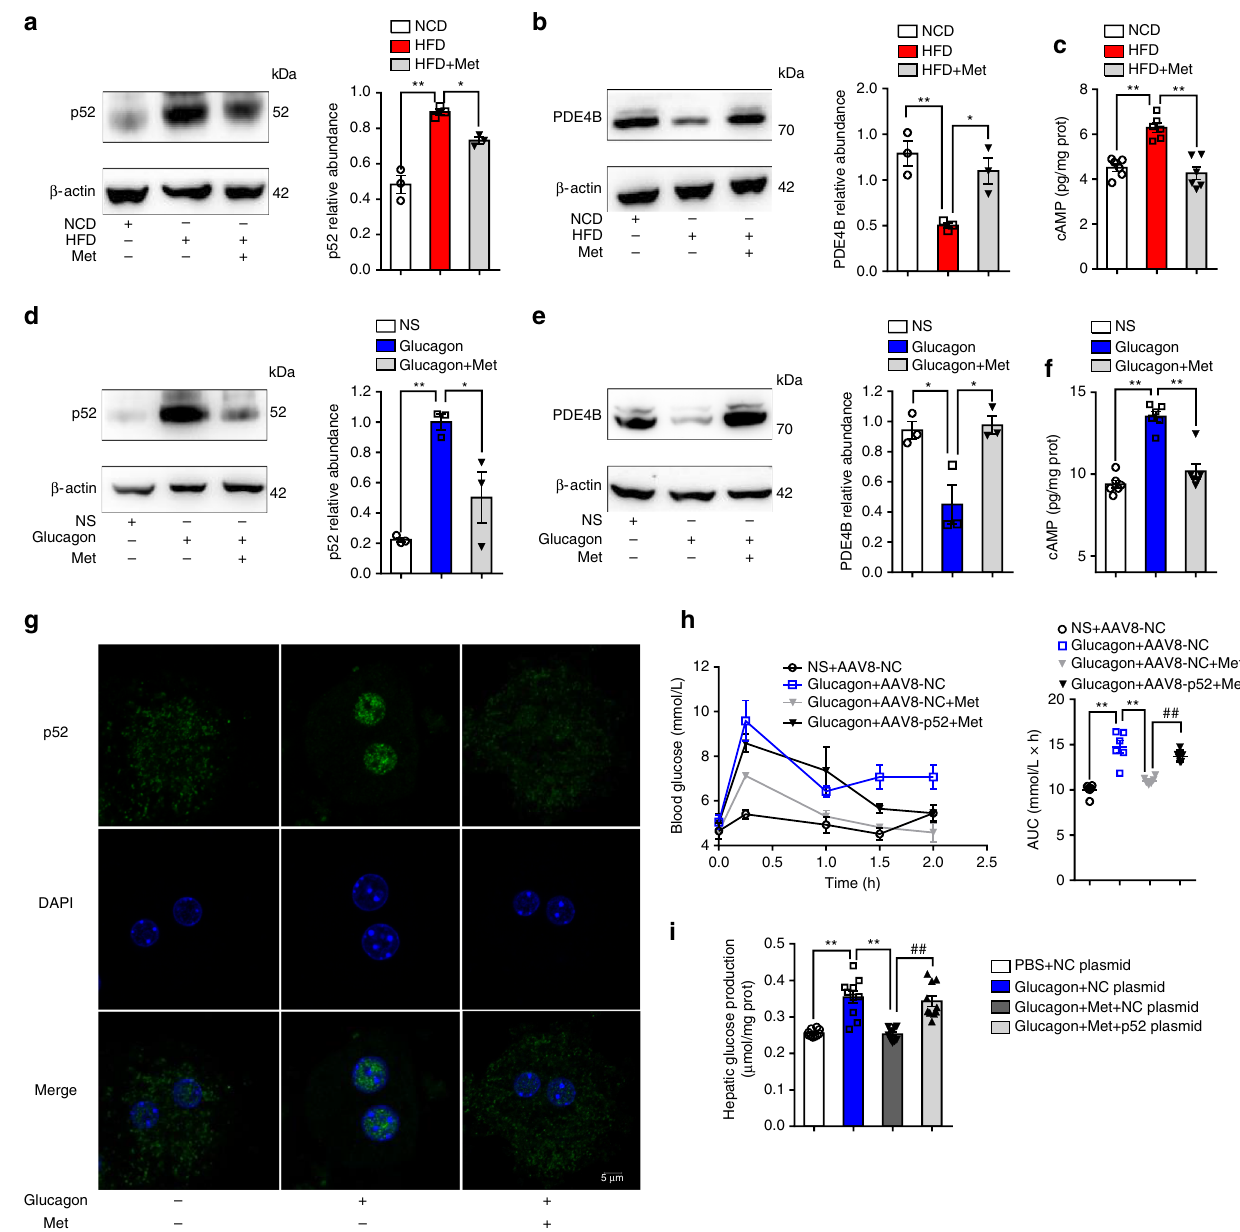
Fig. 5 Metformin alleviates hyperglycemia by inhibiting p52 activation. a , b Western blotting analysis of p52 ( a ) and PDE4B ( b ) using liver lysates of mice fed with the indicated diet for 8 weeks. Each lane represents a liver lysate from a different animal. Bar graphs represent the data normalized to β -actin ( n = 3). Metformin (200 mg/kg/d) was administrated by gavage for 8 weeks. c The cAMP levels in the liver of NCD-fed or HFD-fed mice ( n = 6). d , e Western blotting analysis of hepatic p52 ( d ) and PDE4B ( e ) in mice injected with 2 mg/kg glucagon ( n = 3). In total, 200 mg/kg metformin was pre- administrated by gavage 1 h before glucagon injection. f Hepatic cAMP levels in glucagon-injected mice ( n = 6). g Representative confocal images of primary hepatocytes exposed to glucagon (100 nM, 1 h) pretreated with metformin (1 mM, for 4 h), or PBS. Scale bar represents 5 μ m. h Blood glucose curve and AUC for mice that are either treated with AAV8-p52 or AAV8-NC after glucagon injection ( n = 6). Metformin (200 mg/kg) or normal saline was administrated 1 h before glucagon injection by gavage. i Hepatic glucose production in p52 overexpression primary hepatocytes treated with or without 1 mM metformin ( n = 8). HFD high-fat diet, Met metformin, PDE phosphodiesterase, NCD normal chow diet, NS normal saline, PBS phosphate buffer saline, AUC area under the curve, DAPI 4 ’ ,6-diamidino-2-phenylindole, AAV adeno-associated virus. Bars represent mean ± SEM values. Statistical differences were determined by one-way ANOVA. * p < 0.05 vs. the control group, ** p < 0.01 vs. the control group. ## p < 0.01 vs. AAV8-p52 or p52 plasmid group. Source data are provided as a Source Data fi overexpressed mice (Supplementary Fig. 9d). In addition, we transfected p52 plasmid in primary hepatocytes and detected the hepatic glucose production. The inhibitory effects of Rb1 on overexpressed p52 in mice liver with AAV8-p52 injection. The hepatic glucose production were reversed (Supplementary hypoglycemic effects of Rb1 were diminished in p52 Fig. 9e).